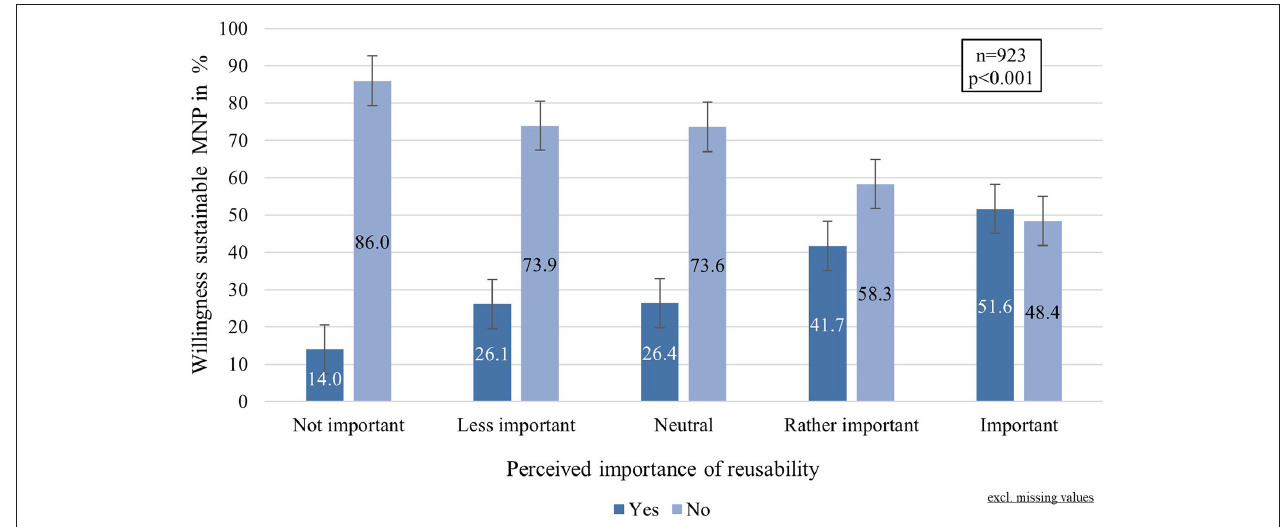
FIGURE 5 | Willingness to choose a sustainable mask by perceived importance of